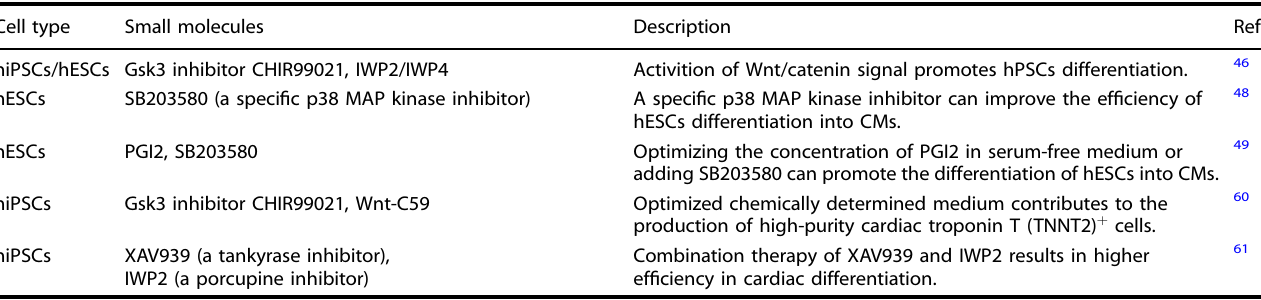
Table 1. Small molecules mediate the differentiation of human pluripotent stem cells into cardiomyocytes Cell